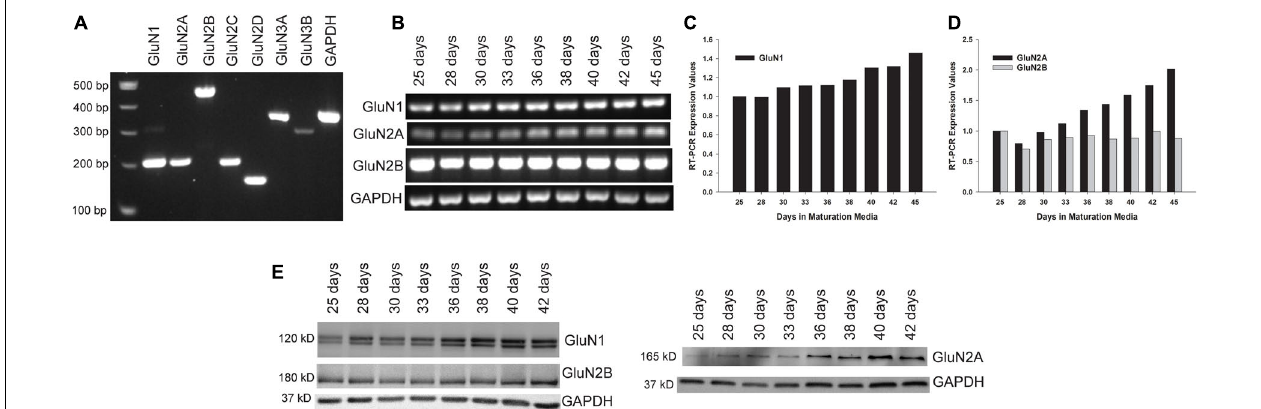
FIGURE 2 | Expression of NMDAR subunits in maturing human neuronal cultures. (A) Reverse transcriptase-polymerase chain reaction (RT-PCR) was performed with RNA harvested from XCL-4 derived mature neuronal cultures (36 days in maturation media) to confirm the expression of several of the NMDAR subunits. (B–D) A time course study was performed with RNA harvested from cultures in maturation media at increasing times starting at 25 days to assess NMDAR subunit expression (B) and displayed quantitatively (C,D) . (E) NMDAR subunit protein expression was assessed by Western immunoblot at various stages of culture